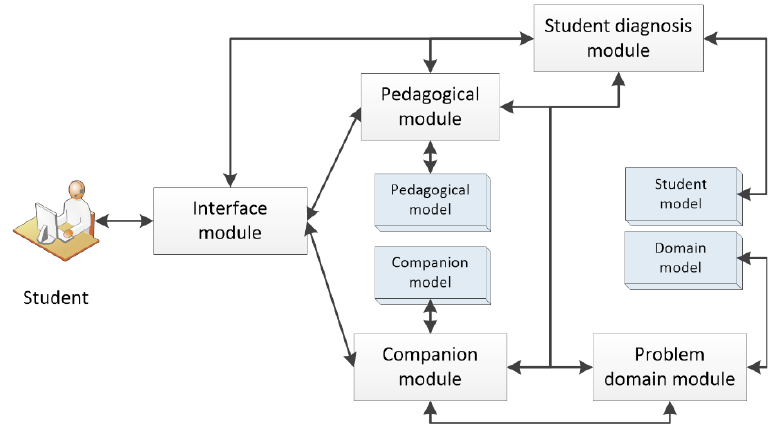
Fig. 1. The general architecture of affective collaborative learning